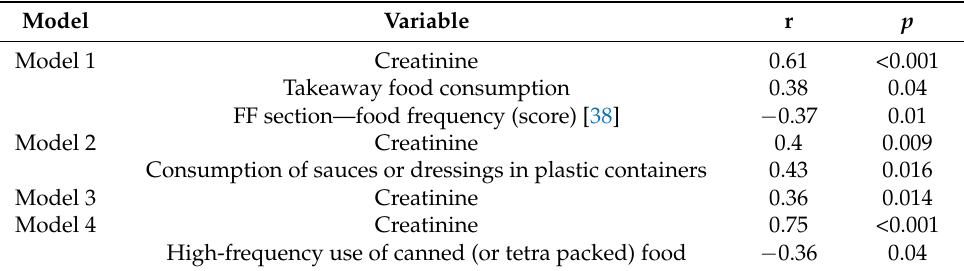
Table 6. Pearson’s correlation analysis (univariable